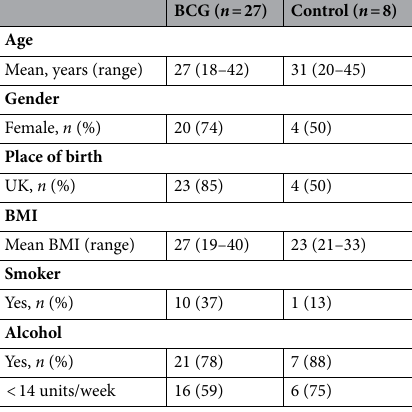
Table 1. Volunteer baseline demographics. Absolute numbers or mean values are indicated with range or percentage in